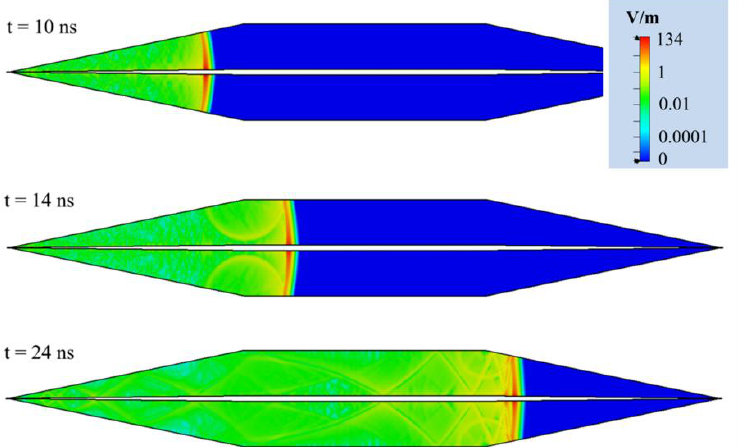
Figure 4. Numerically simulated pattern of the distributions of the modulus of the electric field for the case where a unipolar EMP with duration of 200 ps FWHM is excited in the coaxial line, at three sequential time instants.